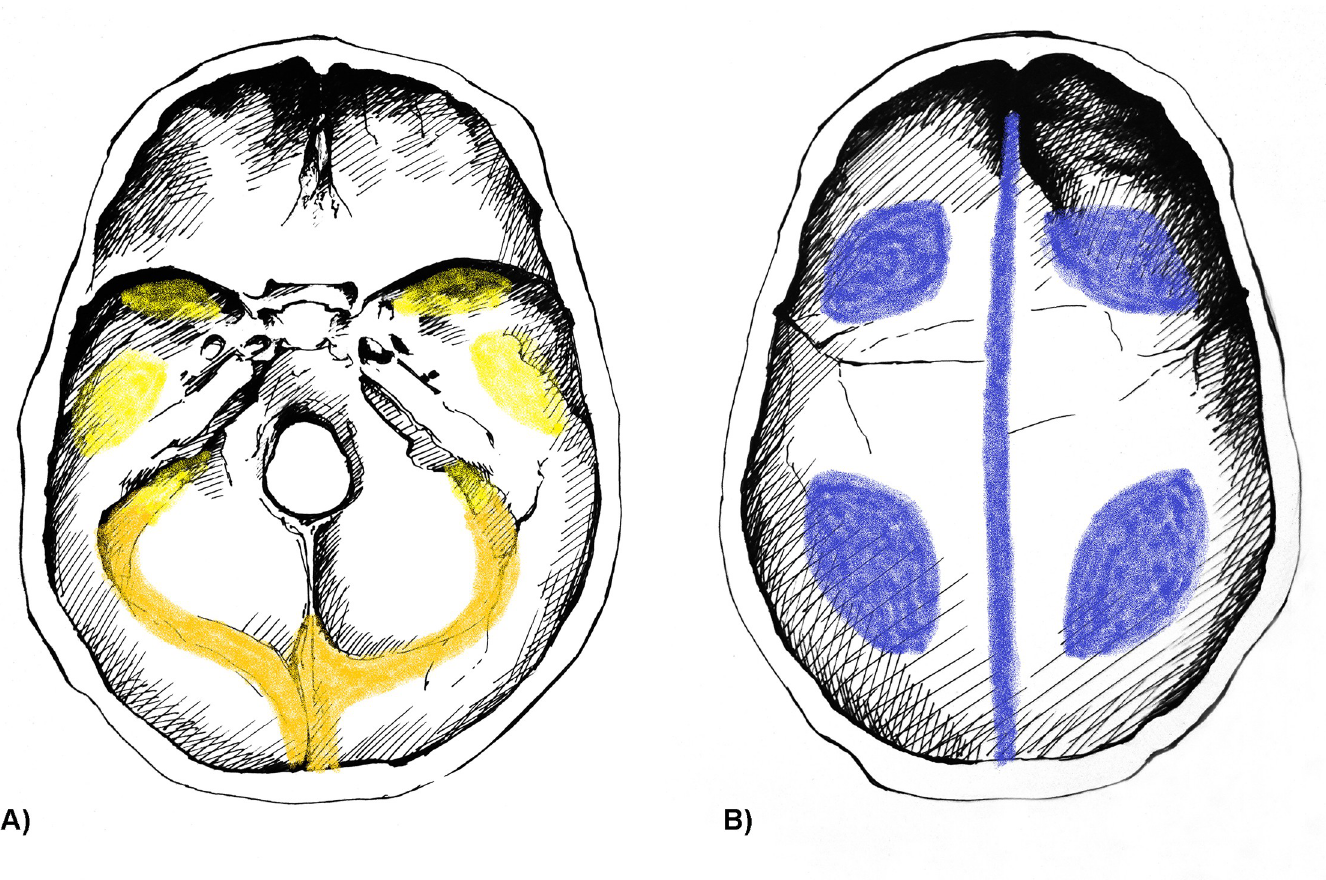
Fig 2. Typical localizations of ABVIs on the inner surface of the A) skull base and B) skullcap. Blue: most commonly affected areas, orange: commonly affected areas, and yellow: less commonly affected areas (drawings by Luca Kis).